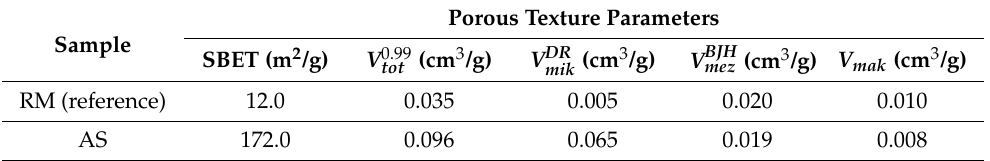
Table 3. Results of the porous texture analysis of samples [45,48].